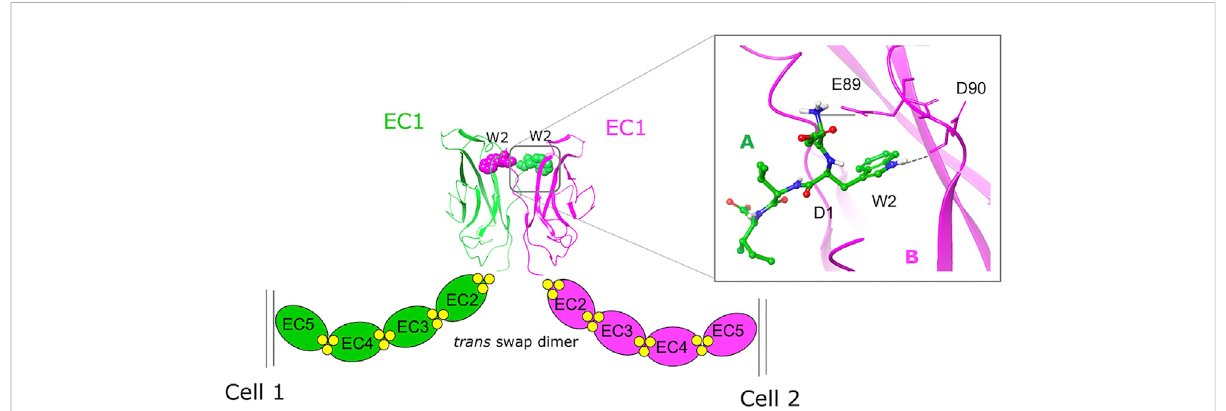
FIGURE 1 AschematicrepresentationofthehomophylicinteractionbetweentypeIcadherinsextracellulardomains.TheW2residuesoftheEC1domains protruding from opposing cells are mutually exchanged (green = monomer A, purple = monomer B) to form the swapped dimer. An expanded view of the swap dimer interface of E-cadherin (2O72.pdb) with the key interactions formed by the N-terminal sequence of monomer A in the hydrophobic pocket of monomer B is also